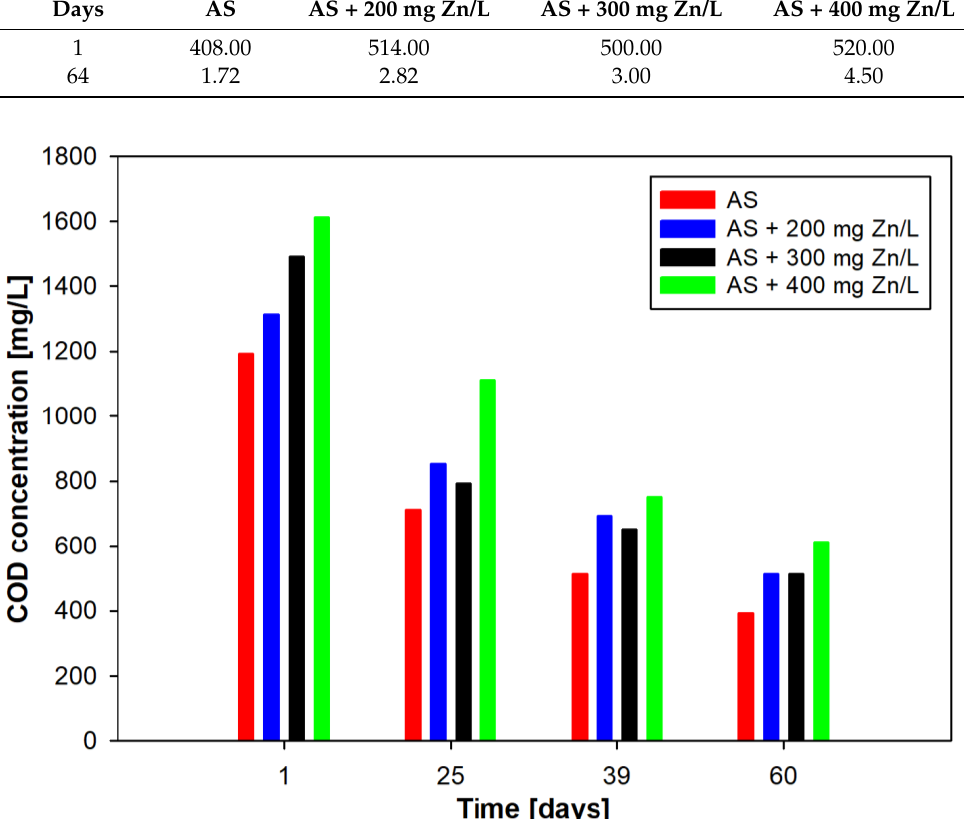
Figure 3. Soluble chemical oxygen demand (sCOD) concentration of the activated sludge (AS) at increasing Zn concentrations at different times of the BMP tests. Values represent a single replicate alternatively sampled from triplicates of each experimental condition.